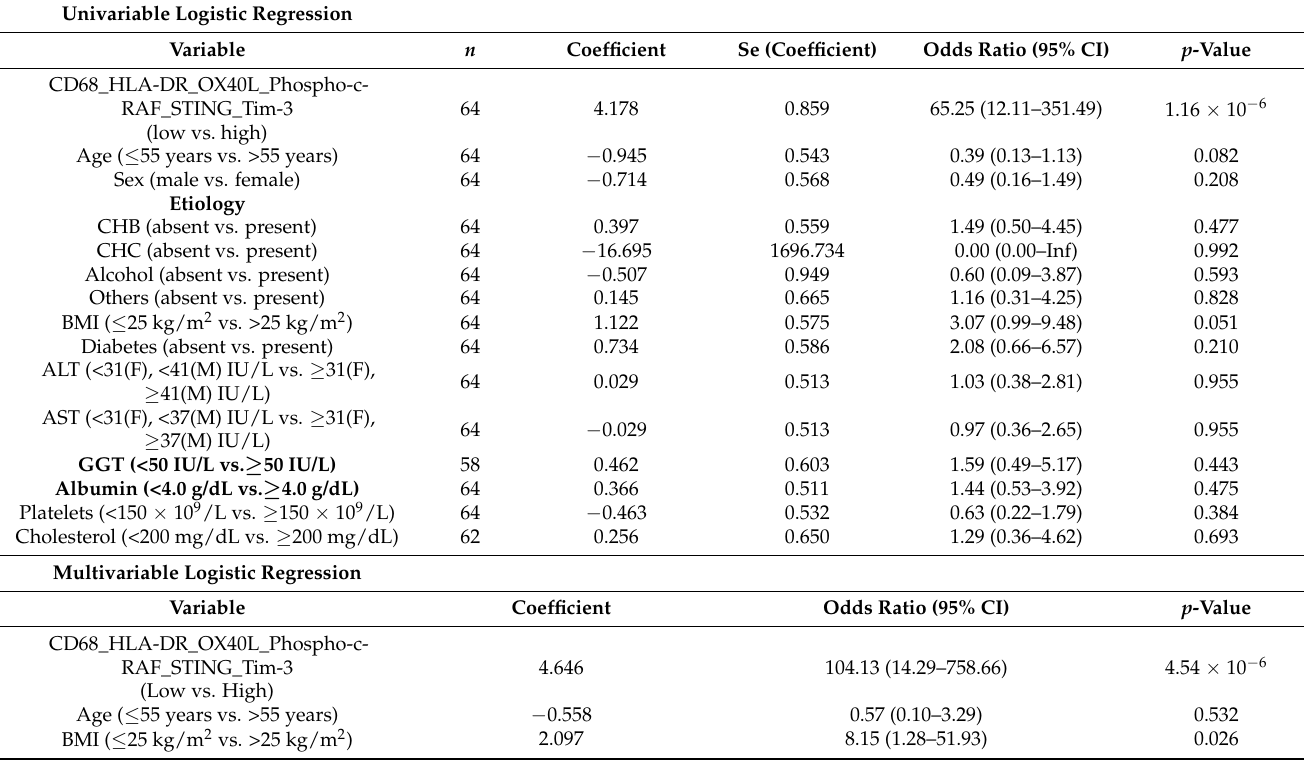
Table 4. Uni/multi-variate logistic regression analysis of factors associated with high-grade fibrosis.